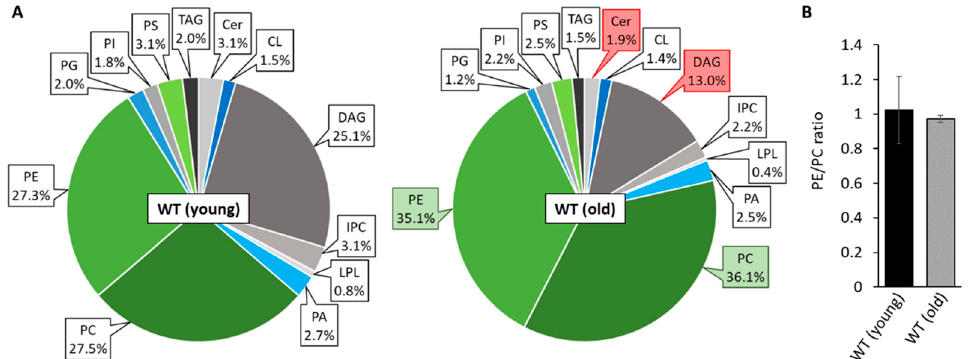
Figure 1. Mitochondrial PL composition changes during aging. ( A ): PL composition of isolated mitochondria of 7-day-old (young) and 21-day-old (old) wild-type (WT) cultures grown under glycolytic conditions. Data represent relative proportion of total lipids. Significantly ( p < 0.05) increased or reduced PLs are marked with green and red boxes, respectively. Exact values (mean ± SD) can be found in supplementary material (Table S1). CL: cardiolipin, Cer: ceramide; DAG: diacylglycerol; IPC: inositol phosphorylceramide; LPL: lyso-phospholipids; PA: phosphatidic acid; PC: phosphatidylcholine; PE: phosphatidylethanolamine; PG: phosphatidylglycerol; PI: phosphatidylinositol; PS: phosphatidylserine; TAG: triacylglycerol. ( B ): PE/PC ratio of 7 and 21-day-old wild type. Data represent mean ± SD (young: n = 11; old: n = 5).